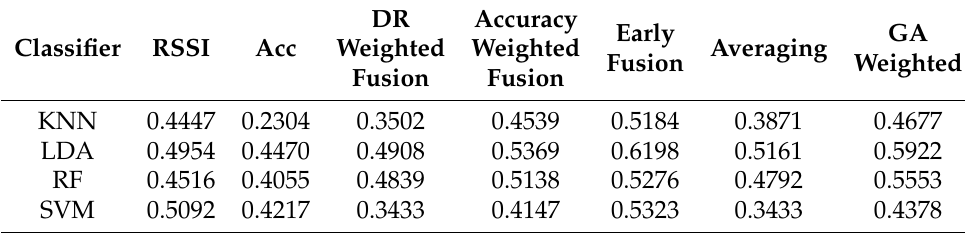
Table 4. Accuracy values for the stairs gateway.